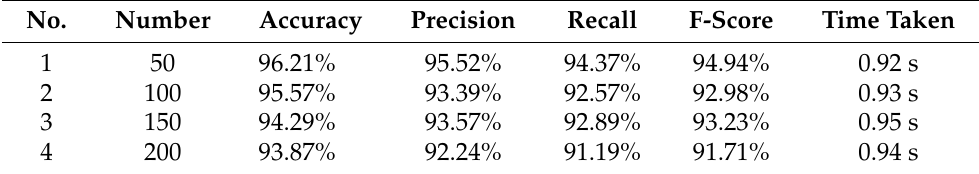
Table 3. Command type a Experimental results.